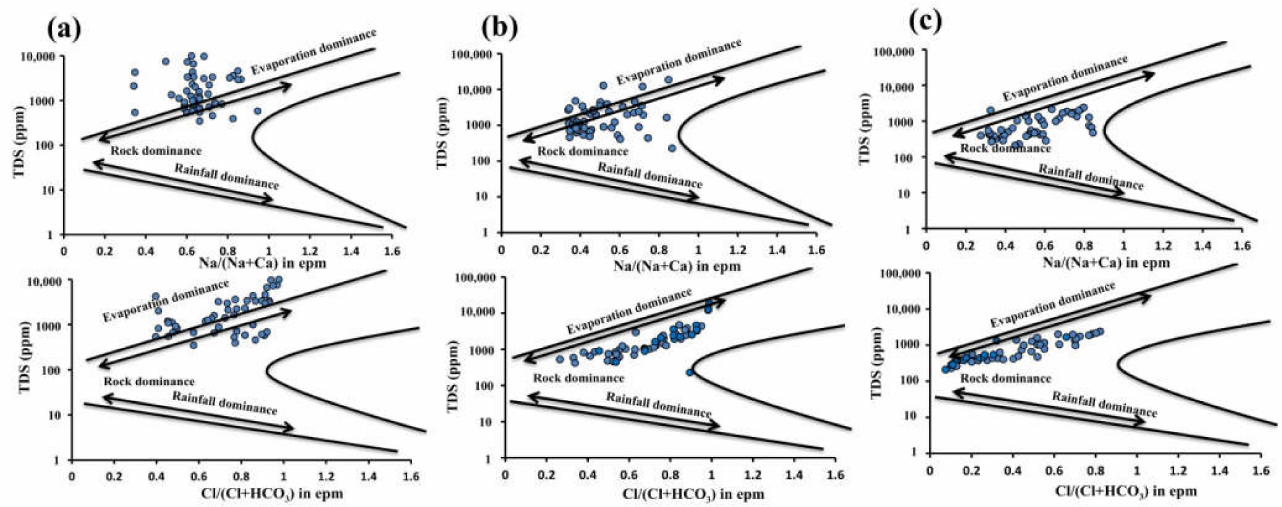
Figure 7. Geochemical controlling mechanisms for selected wadies: ( a ) Wadi Marawani, ( b ) Wadi Fatimah, and ( c ) Wadi Qanunah, Makkah Al-Mukarramah